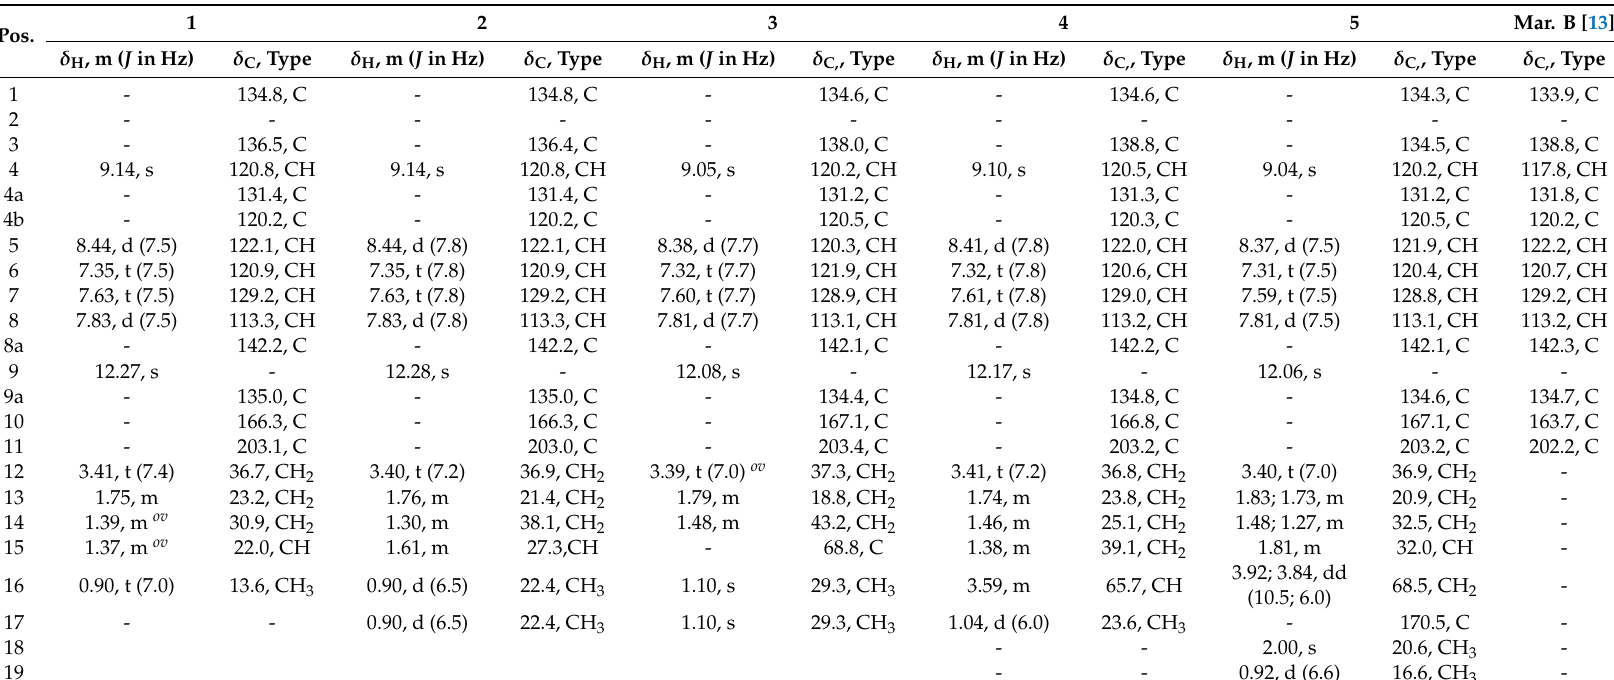
Table 1. NMR data of compounds 1 – 5 in DMSO- d 6 ( 1 H, 700.4 MHz, 13 C, 176.1